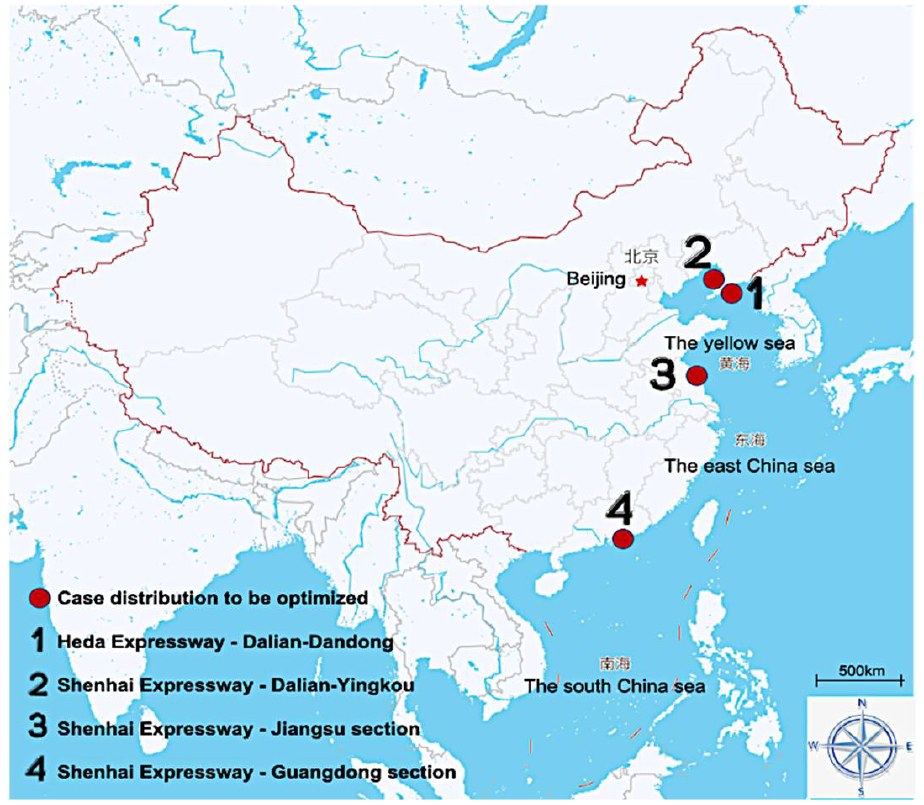
Figure 5. Diagram of case distribution to be optimized (Note: This map is made based on the standard MAP GS (2021) 6375 of AmAP, and the base map is not modified).